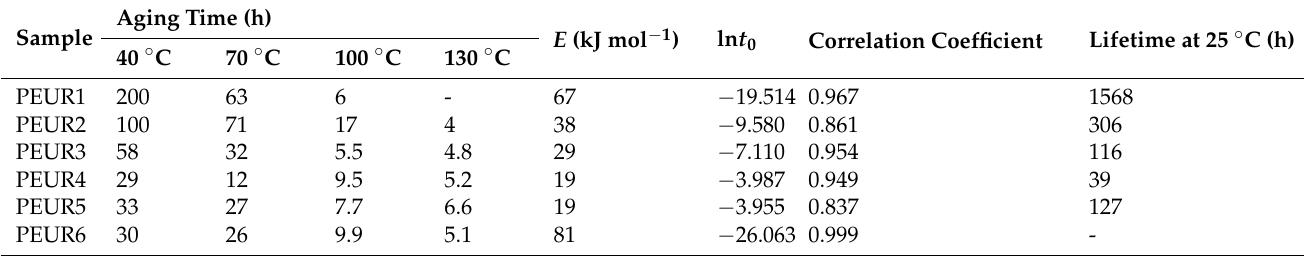
Table 3. Composition, aging times that correspond to the increase in ∆ E value from 0 to 5 and kinetic parameters obtained from Arrhenius plot for PEURs.